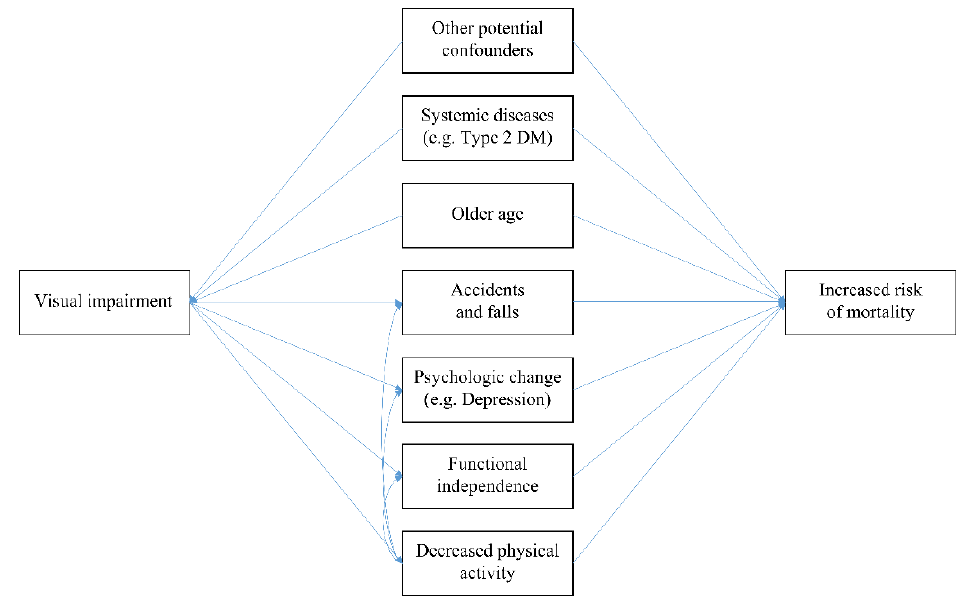
Figure 1. Directed acyclic graph for the association between visual impairment and mortality.